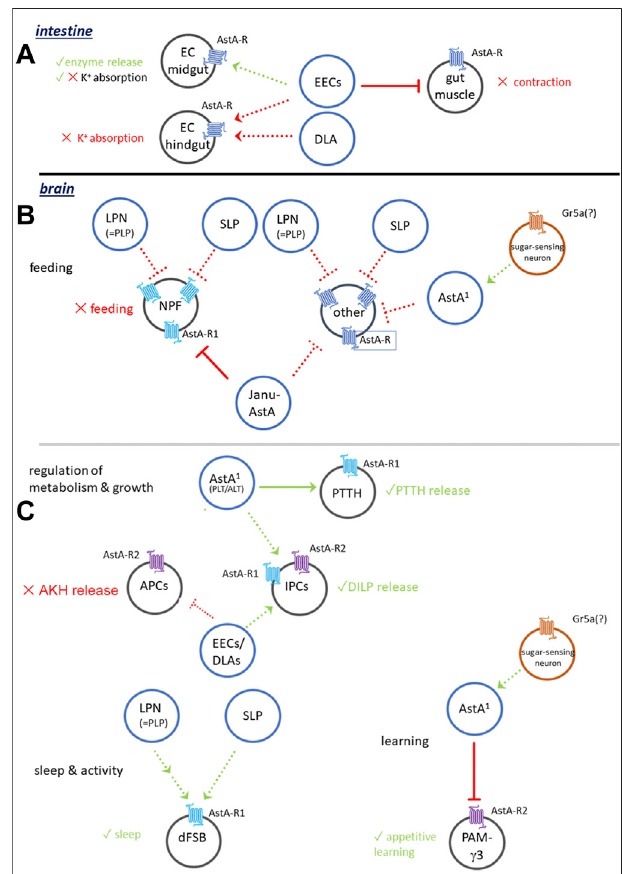
FIGURE 2 | Generalised model of AstA signalling in Drosophila . (A) Functions in the intestinal tract. (B) AstA signalling in the regulation of feeding. (C) AstA signalling in the regulation of metabolism and growth, sleep and activityandlearning.Fordetailssee Section3.1.1 , Section3.2 .Dashed connections are